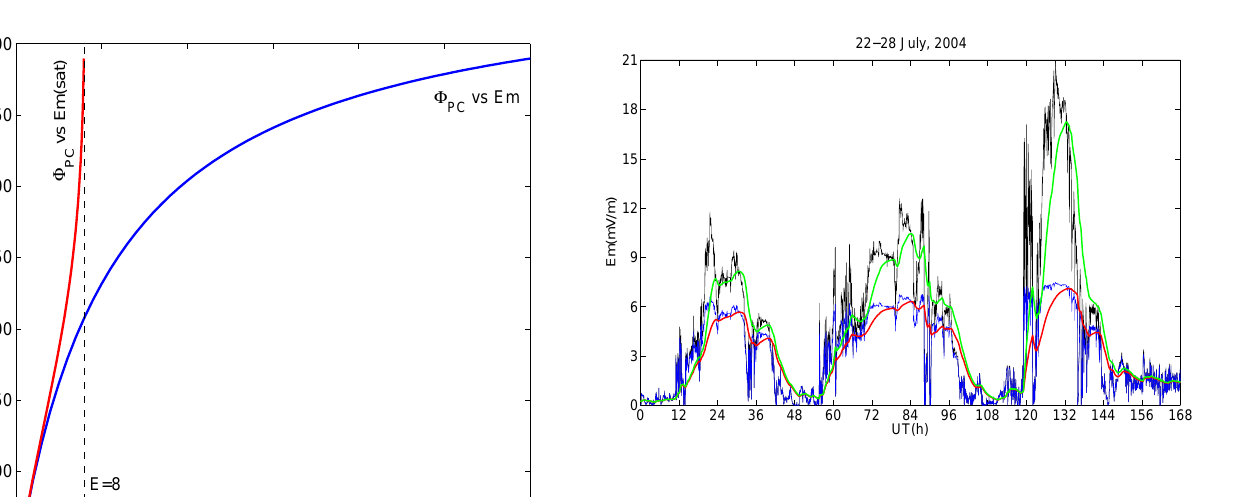
Fig. 2. Comparison of the various types of E m during the storm time 22–28 July 2004. The black curve shows E m directly derived from ACE measurements, The blue curve shows E m ( sat ) truncated to 8mV/m, the red and green curves show the 3h-integrated E m ( sat ) and E m with and without truncation,